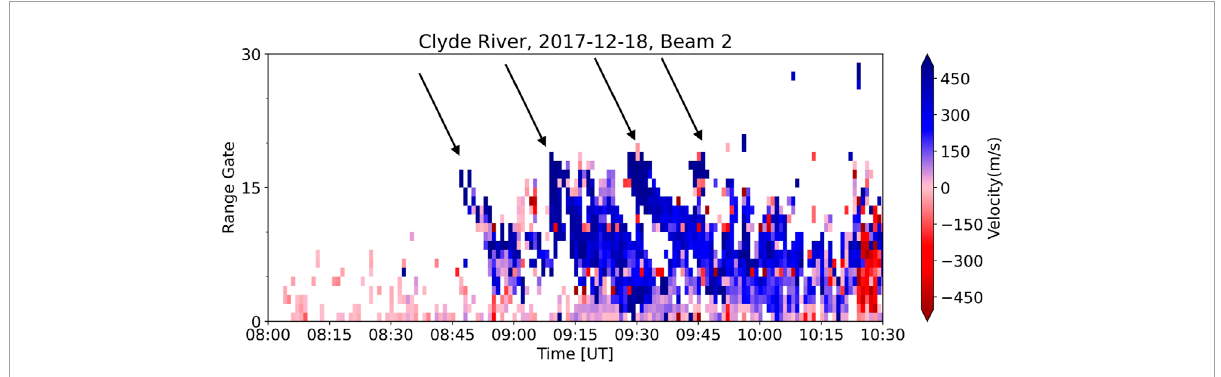
FIGURE 3 Range-time-parameter (RTP) plot of the line-of-sight velocity from beam two of the Clyde River radar at 08:00–10:30 UT on 18 December 2017. Arrows show ionospheric signatures of flux transfer